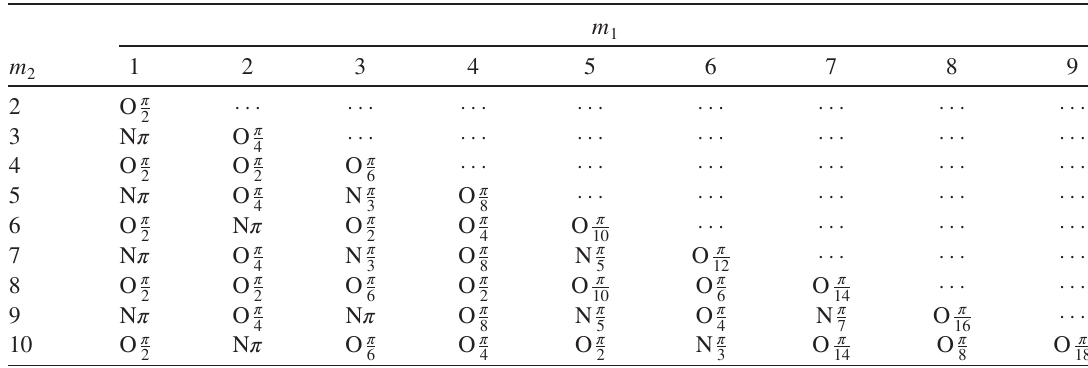
TABLE II. The η values of the first nonforbidden TM ϕ ð q Þ comma) and ϕ m 2 (right of comma). m 2 ¼